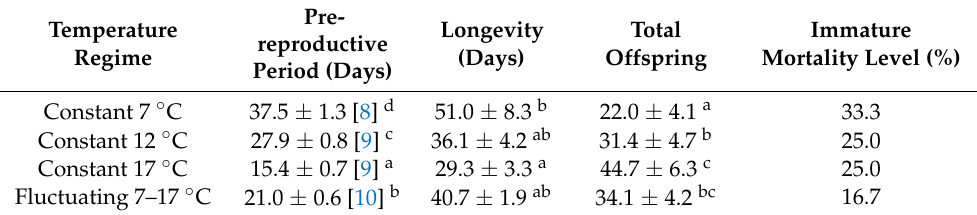
Table 1. Life parameters (mean ± SE) for Dysaphis plantaginea aphids exposed to three constant temperature regimes (7 ◦ C, 12 ◦ C, and 17 ◦ C) and one fluctuating temperature regime (7–17 ◦ C). N = 12 for all parameters, except for the pre-reproductive period, because some aphids did not reach the adult stage (N indicated in brackets for this parameter). Lowerscript letters indicate significant differences ( p < 0.05) among temperature regimes for each measured parameter.